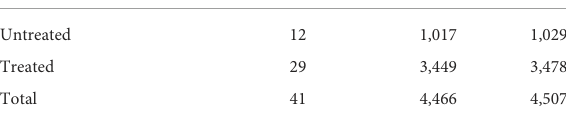
TABLE 5 The common range of supported